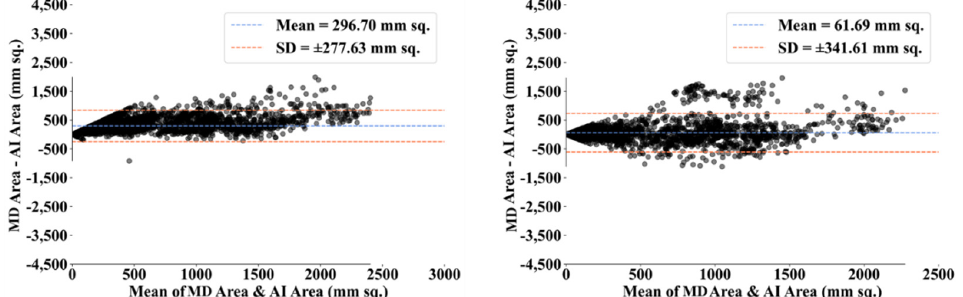
Figure 26. BA plot for PSPNet using MD 1 ( left ) vs. MD 2 ( right ).